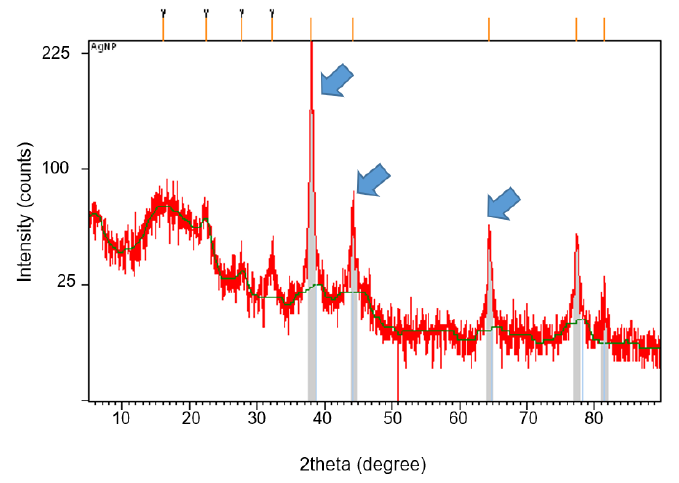
Figure 3. XRD analysis of bioAgNPs synthesized by Streptomyces sp. PBD-311B supernatant. Arrows indicate the main diffraction peaks of bioAgNPs positioned at 38.1°, 44.2°, and 64.4°.